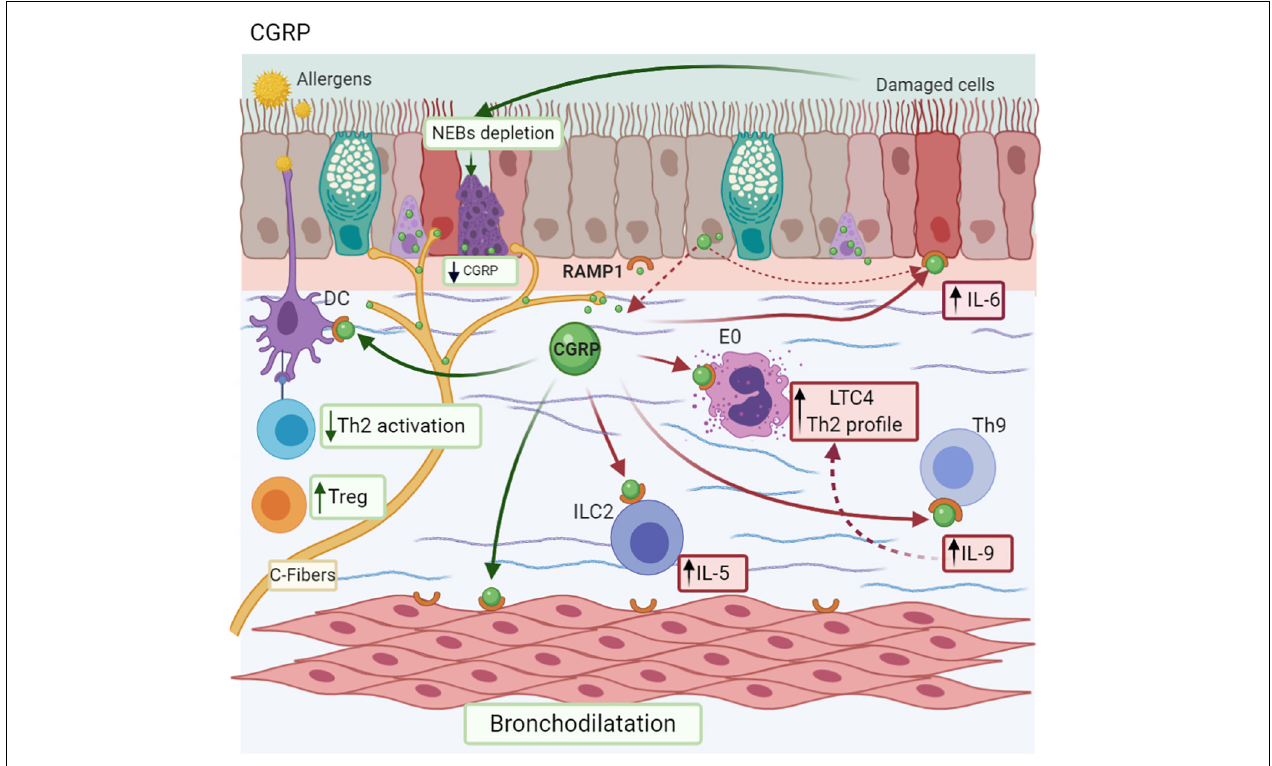
FIGURE 6 | Calcitonin gene-related peptide-CGRP. CGRP is synthesized and stored in C-fibers, neuroepithelial bodies (NEBs), and the epithelium. CGRP promotes a Th9 profile after allergen exposure by RAMP1 activation; IL-6 secretion by the bronchial epithelium; and IL-5 synthesis by ILC2 cells. Additionally, epithelial damage provokes NEBs depletion with the subsequent decrease in CGRP levels. Depending on the context, it also causes bronchodilation and promotes Treg differentiation, reducing Th2